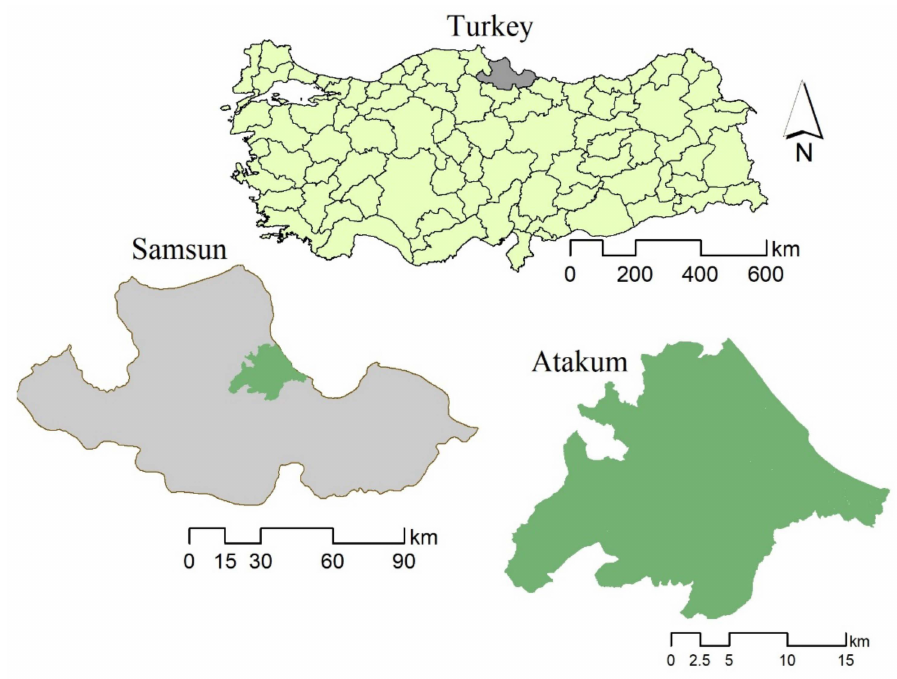
Figure 1. Location of the study